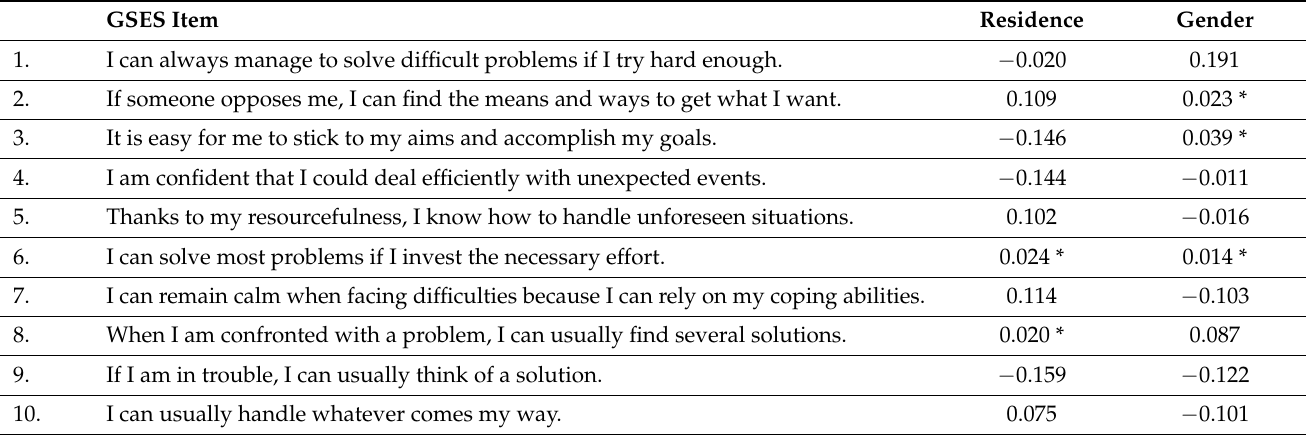
Table 7. Correlations between GSES items and demographic